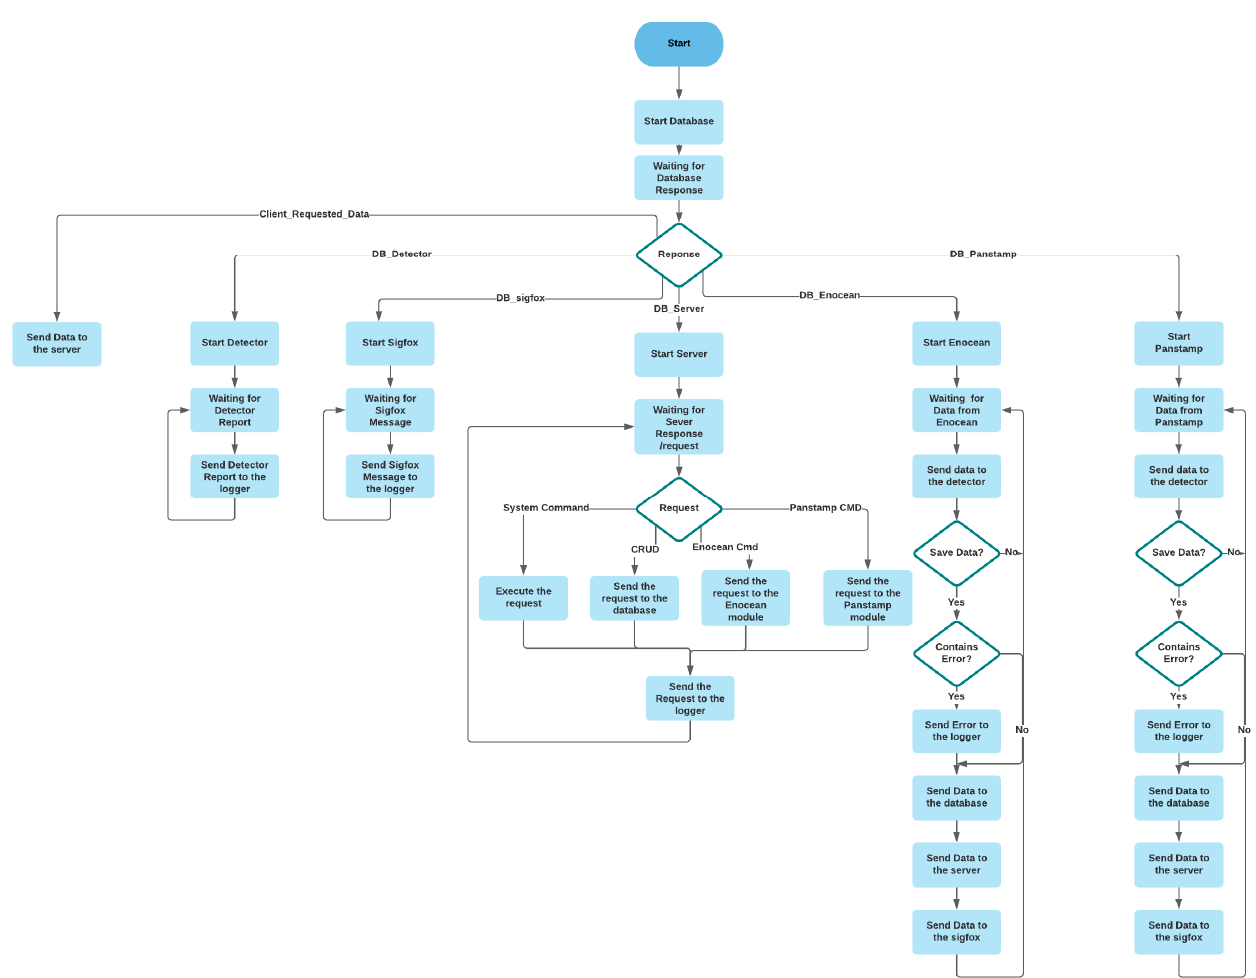
Figure 11. The flowchart of the core module.